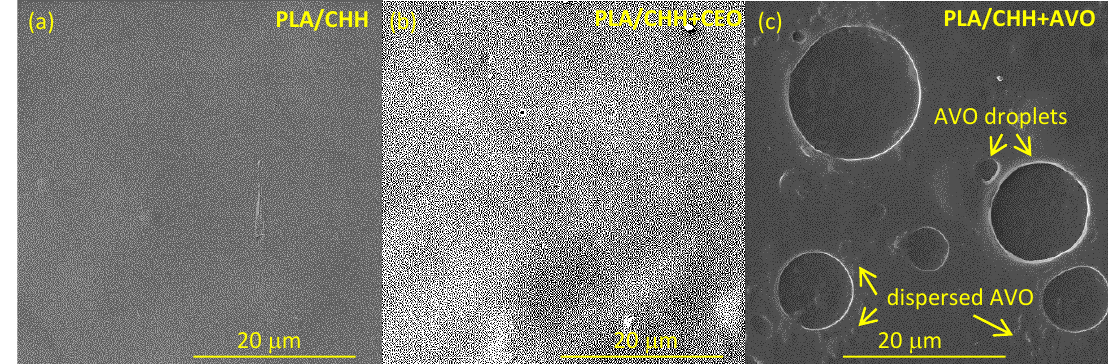
Figure 1. SEM micrographs of PLA samples surface modified with plant oil-loaded chitosan coatings: ( a ) PLA/CHH, ( b ) PLA/CHH-CEO, and ( c ) PLA/CHH+AVO.